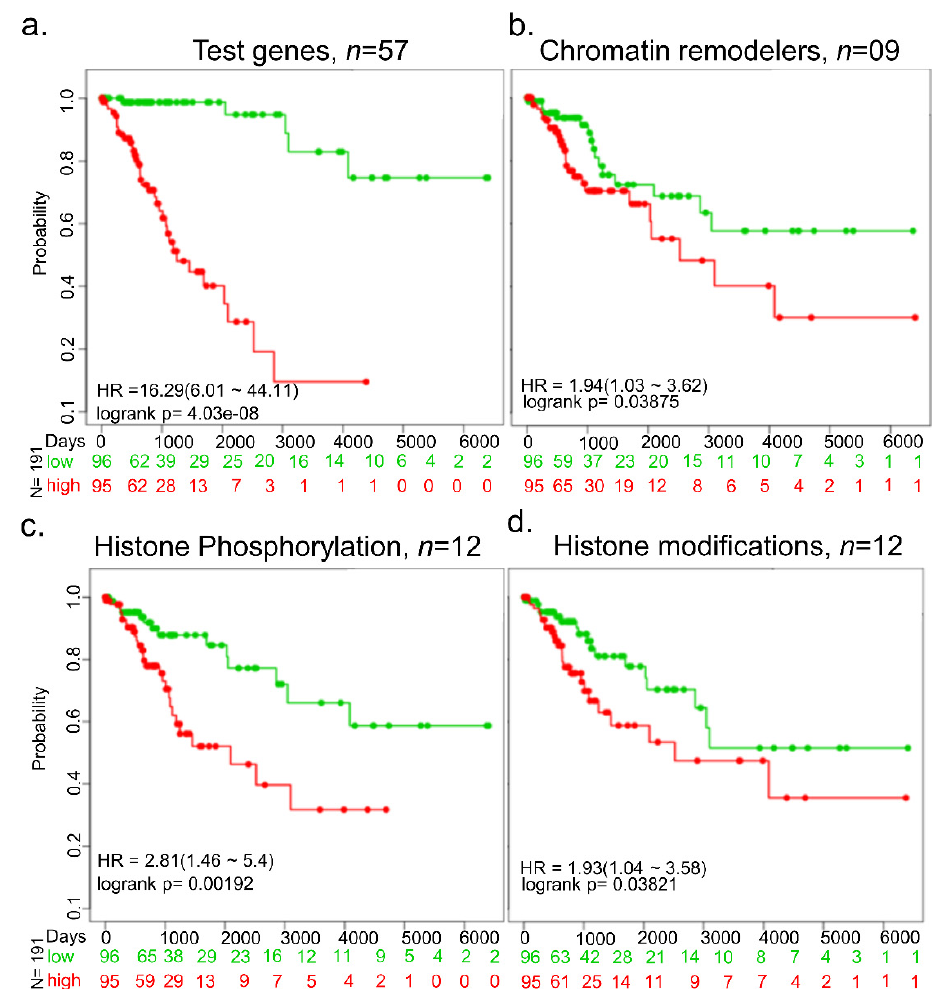
Figure 3. Survival analysis of cervical cancer-specific epigenomic and chromatin genes. ( a ) Analysis using 57 epigenomic and chromatin modifiers genes. ( b ) Analysis using 9 chromatin remodeler genes. ( c ) Analysis using 12 histone phsphorylation genes. ( d ) Analysis using 12 histone modification genes. Numbers below the X-axis represent the number of patients not facing an event for a long time for each group. N represents the number of total cervical cancer